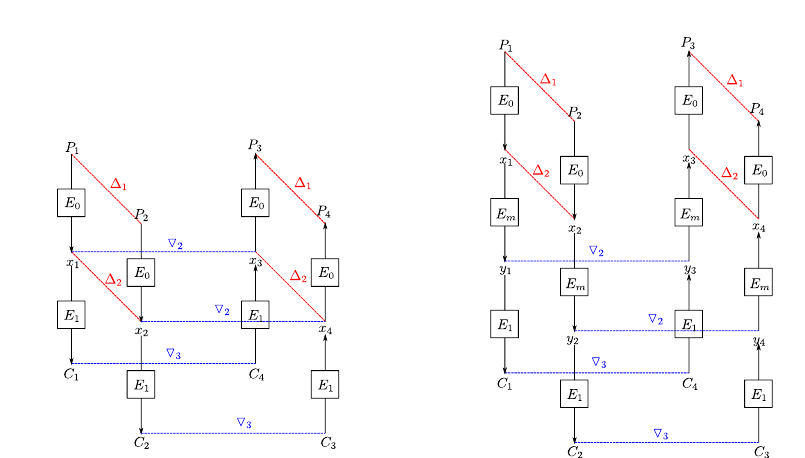
Figure 1: Basic boomerang attack(left) and Sandwich attack(right)